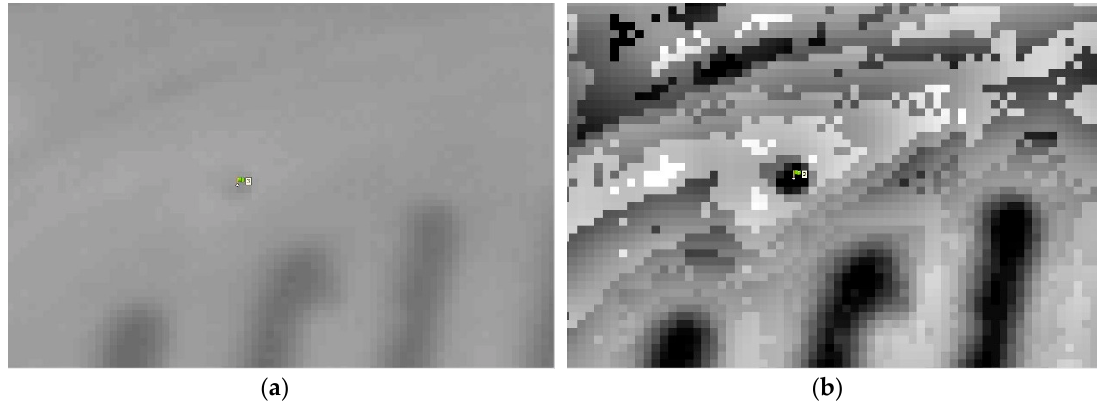
Figure 4. Example of photointerpretation in non-filtered images ( a ) and filtered images ( b ).